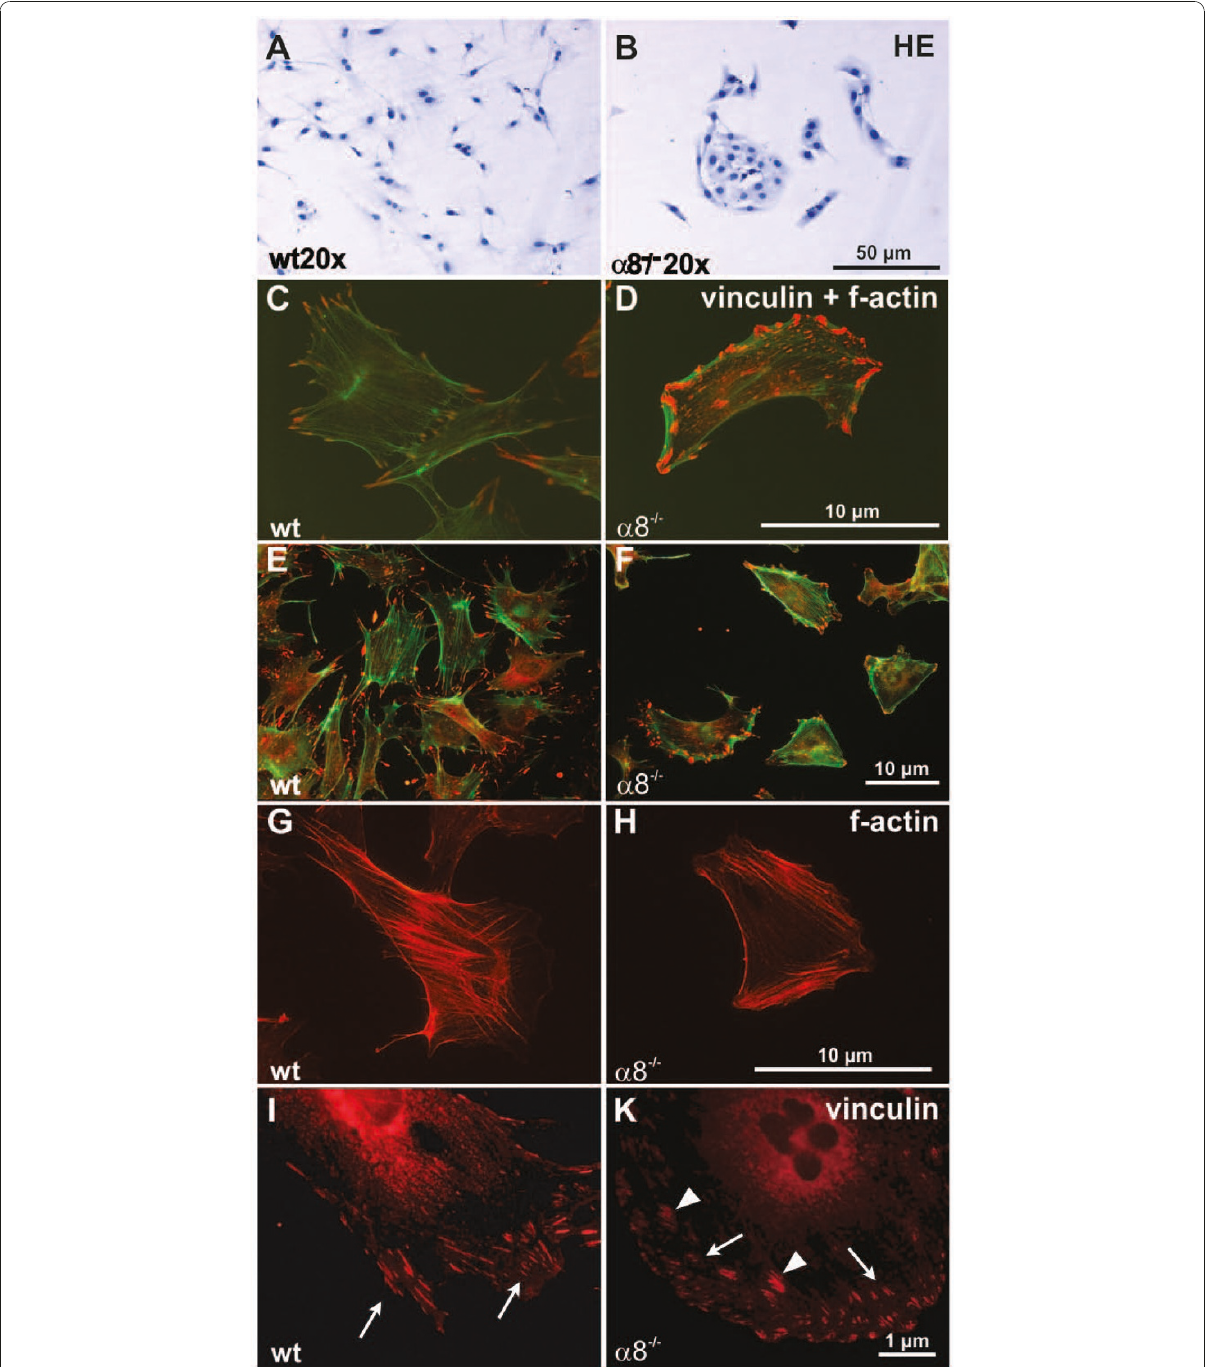
Figure 2 Comparison of wild type (wt) and a 8 integrin-deficient ( a 8-/-) mesangial cell morphology after hematoxylin stain (A+B), immunofluorescent double staining for f-actin in green and vinculin in red (high magnification C+D, low magnification E+F), immunofluorescent staining for f-actin alone (G+H) or immunofluorescent staining for vinculin alone (I+K) . White arrows indicate focal contacts of the cells and white arrowheads indicate bundles of focal contacts in a 8-/- mesangial